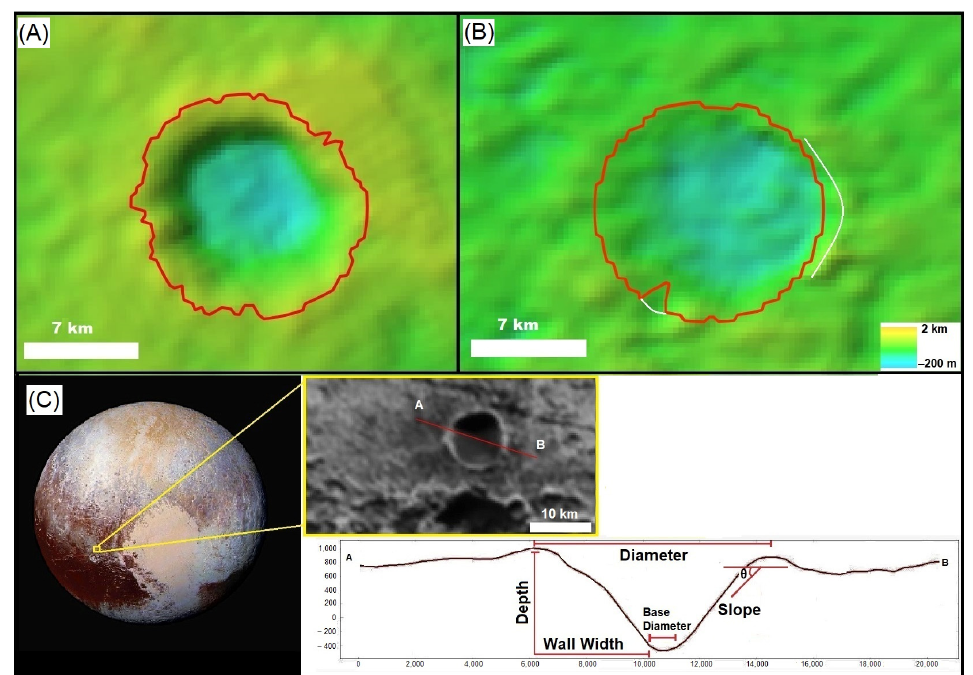
Figure 3. ( A ) Crater with a good outline. ( B ) Crater with some outline errors and, therefore, excluded from further analysis. The red lines represent the outlines processed by the Python code for two different craters, each one with different levels of success. White lines represent the ideal outline. ( C ) Profile of a simple crater on Pluto ’ s surface showing the data extracted by the Python code.